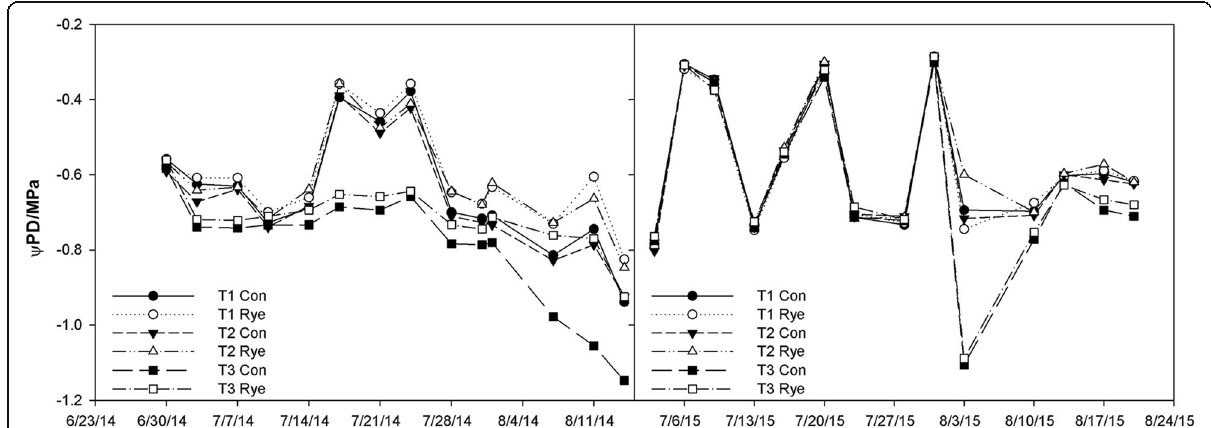
Fig. 2 Predawn leaf water potential readings ( Ψ PD ) for cotton grown under irrigation regimes T1-T3 and planted into either conventionally tilled beds (Con) or a heavy rye cover crop residue (Rye) during the 2014 and 2015 growing season near Tifton, GA. There were six replicate plots per treatment, and 3 Ψ PD readings were averaged for each plot prior to analysis